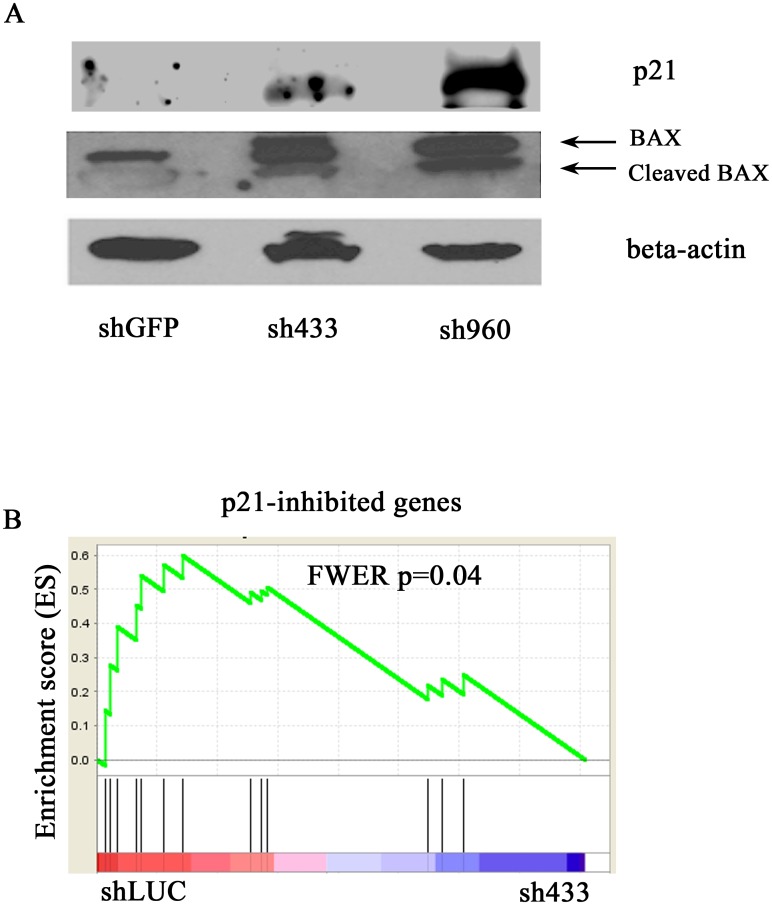
Knockdown of HSPA9 increases expression of the TP53 target genes p21 and BAX in CD34+ cells.(A) Representative immunoblot of p21 and BAX following knockdown of HSPA9 in CD34+ cells. (B) Gene Set Enrichment Analysis (GSEA) enrichment score plot for 13 annotated p21-inhibited genes. Individual genes in the gene set are represented by a black vertical bar in the middle of the plot.